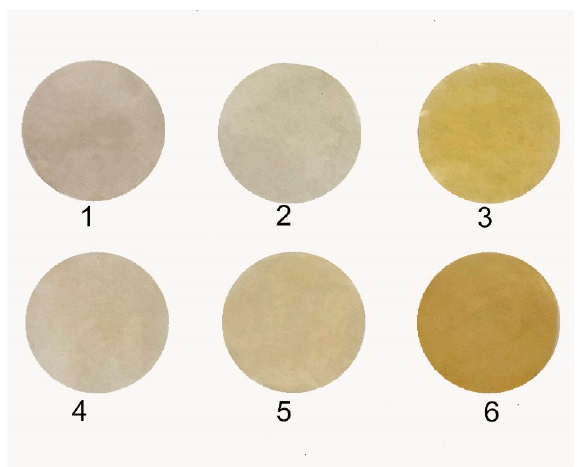
Figure 3 . Changes in visual appearance of quaternized samples 1–6. Figure 3. Changes in visual appearance of quaternized samples 1–6.